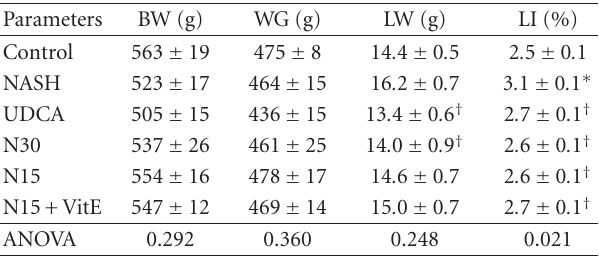
Table 1: E ff ect of treatments on body and liver